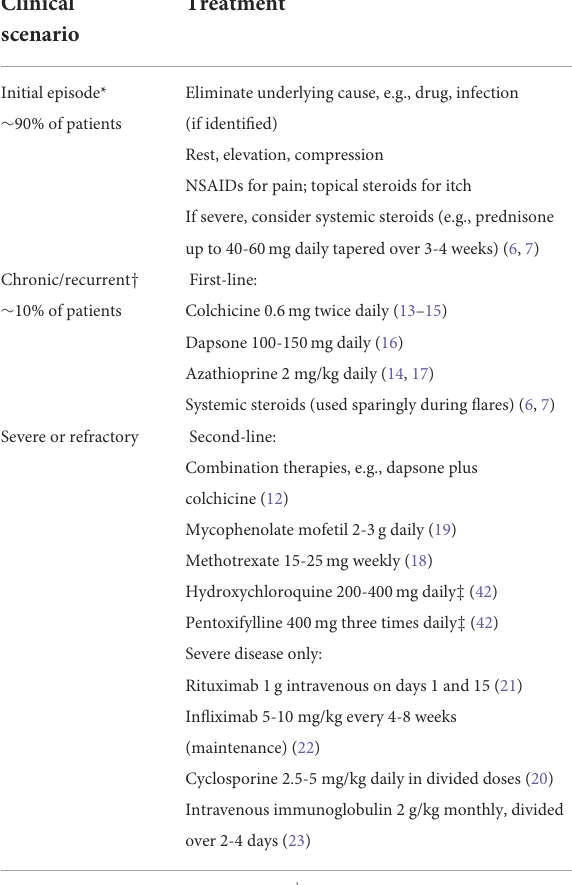
TABLE 2 Expanded treatment ladder for skin-limited cutaneous small vessel